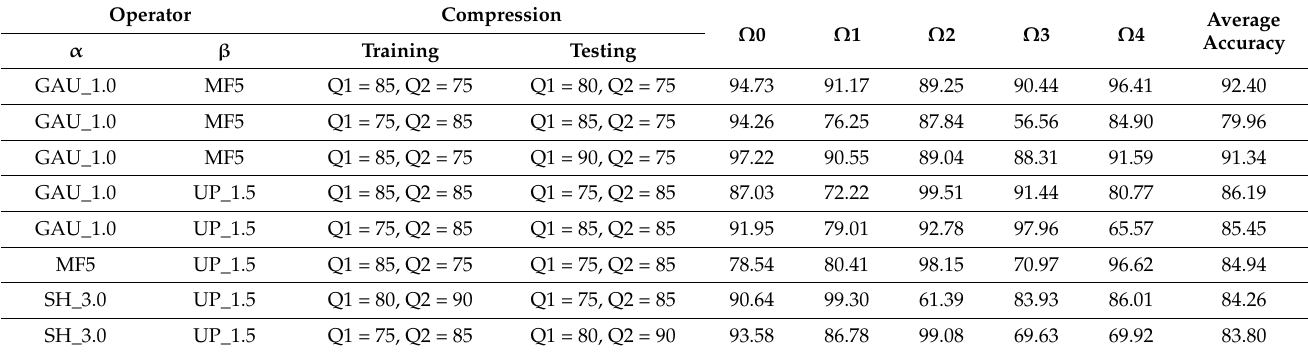
Table 5. Detection for dissimilar JPEG compression quality